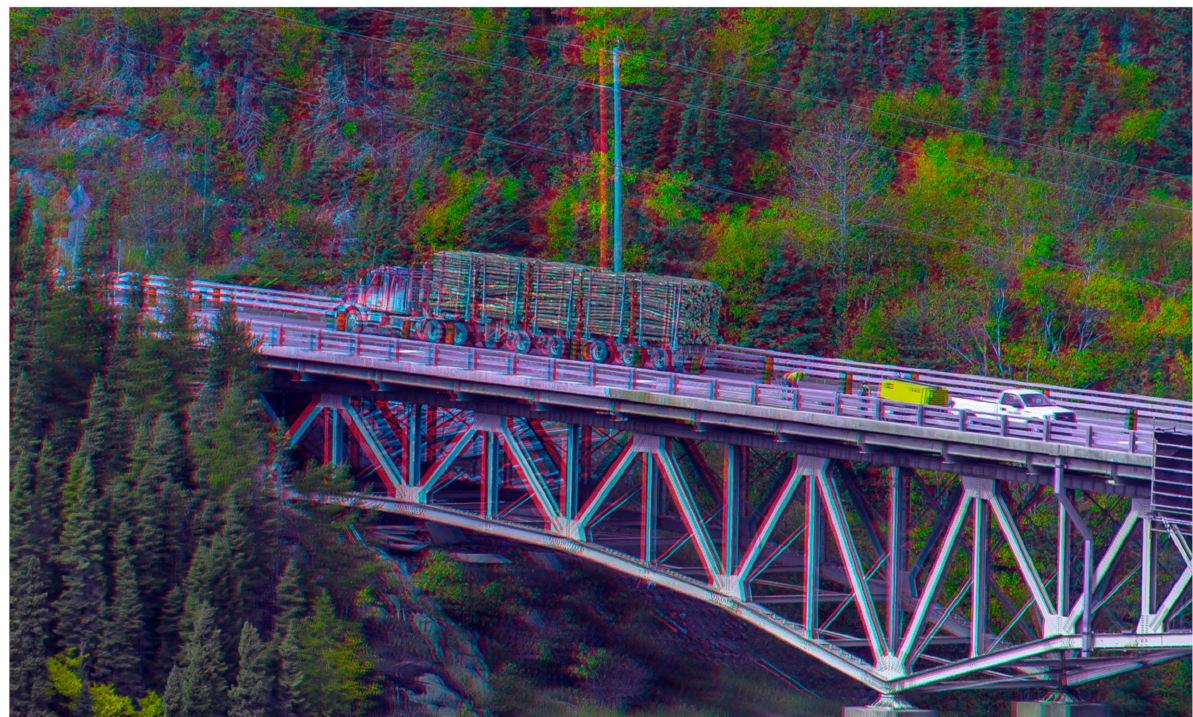
Figure 13. ‘Trans-Canada Highway @ Neyes National Park’ (2014) by Sascha Becher. © Sascha Becher. Used with permission from: https://www.flickr.com/photos/stereotron/30208366315 (accessed on 30 September 2020). For more of Sascha Becher’s telestereoscopic images please see: https://www.flickr.com/photos/stereotron/ (accessed on 30 September